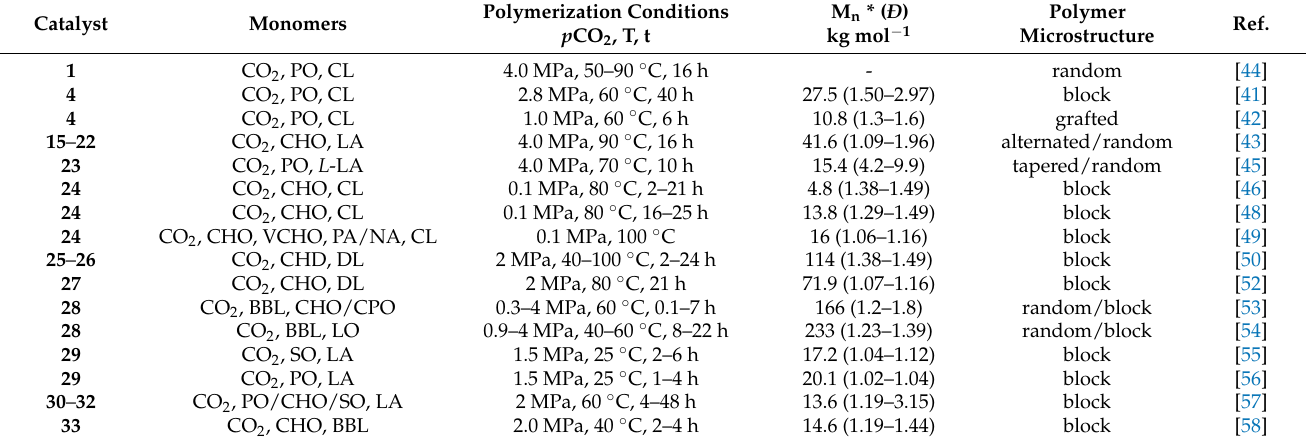
Table 2. Summary of terpolymerization of CO 2 with epoxides and cyclic